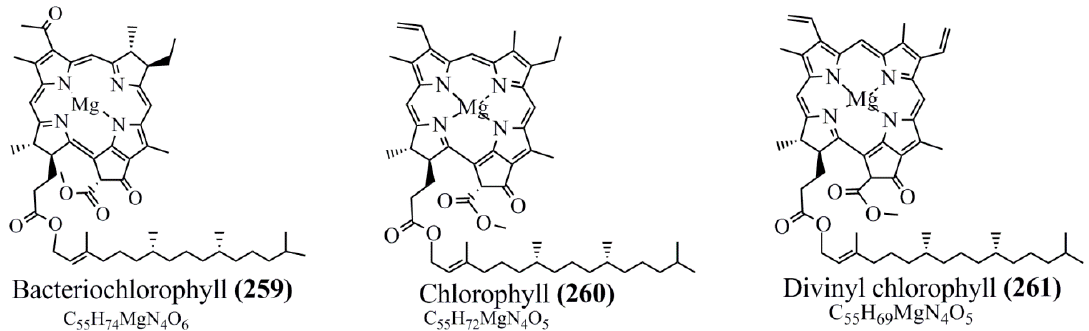
Figure 1. Chemical structures of various